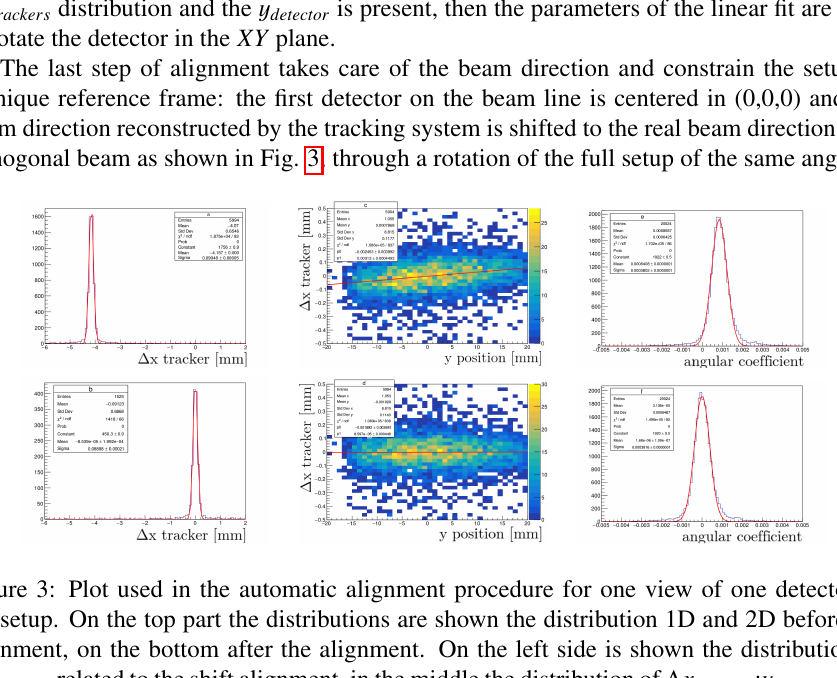
∆ x trackers : y detector used